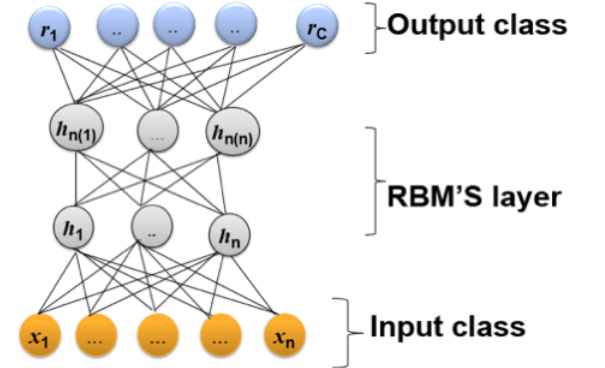
Figure 4. Diagram of a Deep Belief Network (DBN) architecture.